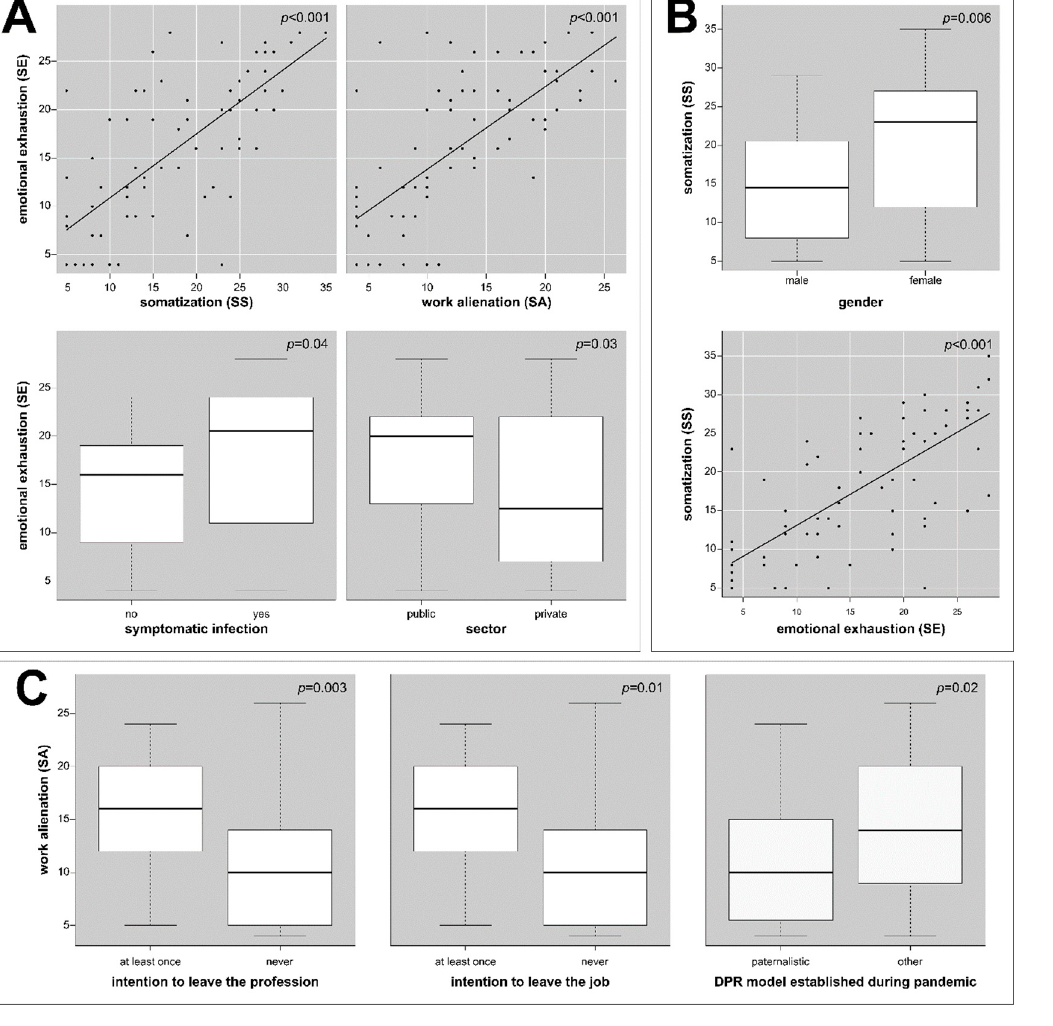
Figure 1. Scores of emotional exhaustion ( A ), somatization ( B ), and work alienation ( C ) by variables with statistical significance in Ecuadorian physicians who worked with COVID-19 patients. SE, scale of exhaustion; SS, scale of somatization; SA, scale of alienation.